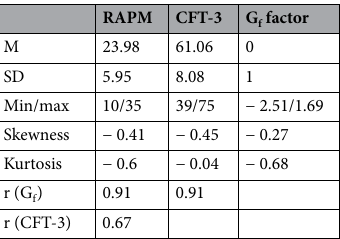
Table 3. Descriptive statistics and correlations (Pearson’s r) for the intelligence tests used to extract the G f factor (n = 65). RAPM, Raven’s Advanced Progressive Matrices; CFT-3, Cattell Culture Fair Intelligence